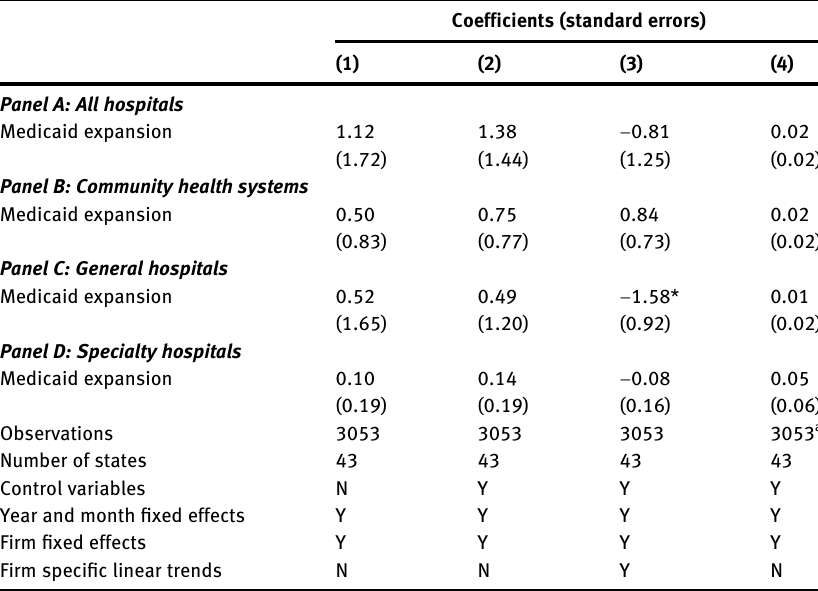
Table  : The impacts of Medicaid expansion on the number of nonpro fi t